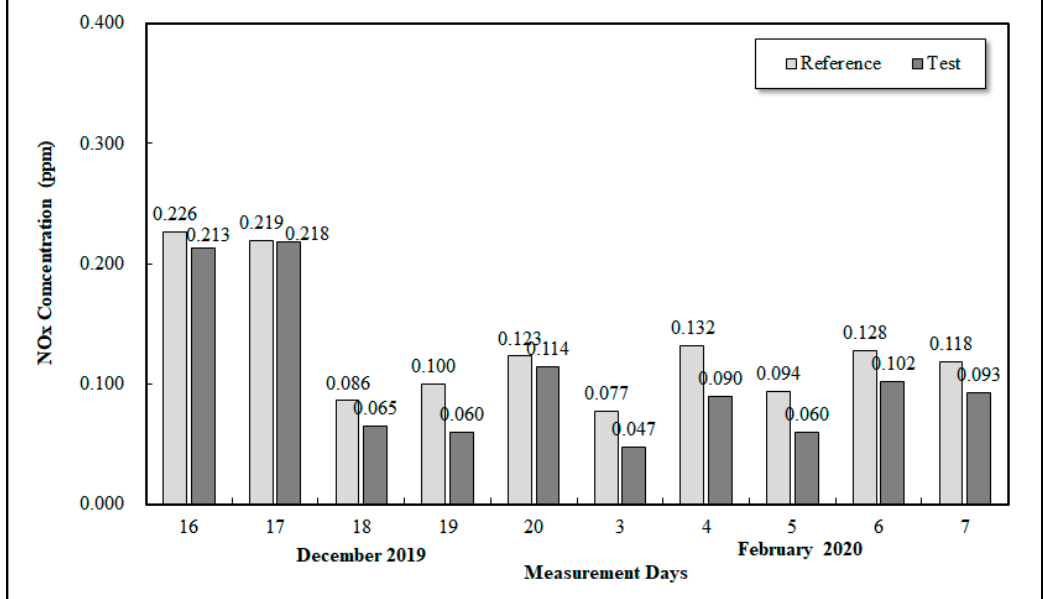
Figure 3. Means of NOx concentration on the test and reference section in measurement days.